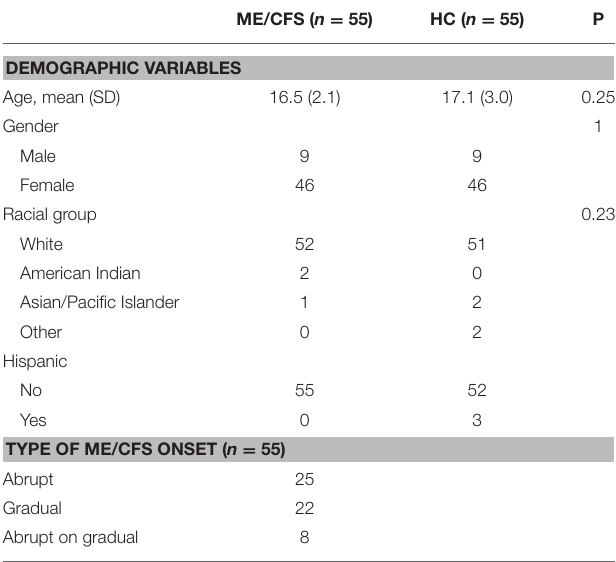
TABLE 1 | Demographic and clinical characteristics of the study